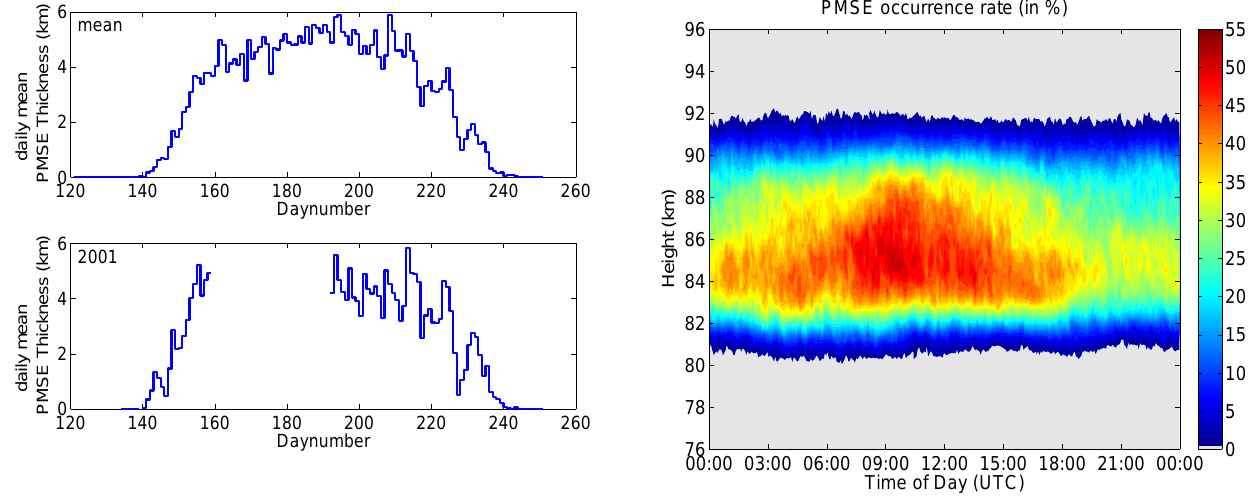
Fig. 5. Mean PMSE occurrence as a function of height and time. All mesosphere measurements during the summers 1999–2001 and 2003–2004 were analysed and combined. The maximum PMSE occurrence rate is observable over a wide height range (about 83- 89 km) at the same time